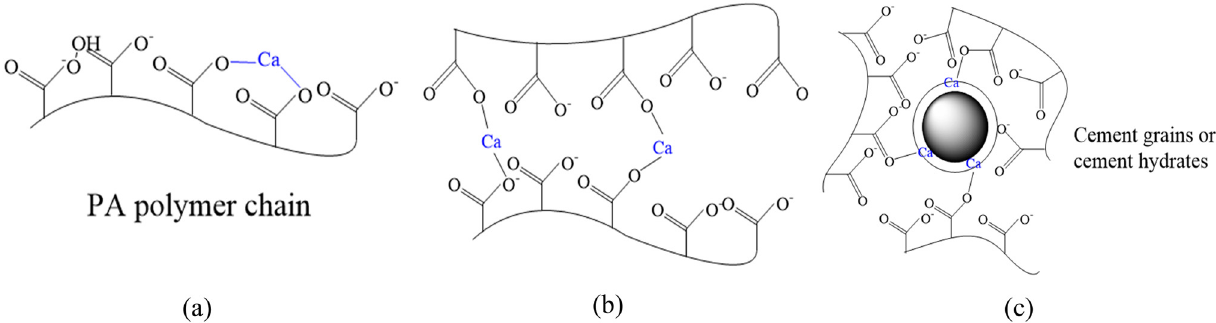
Figure 10: Reactions between Ca 2 + and polyacrylate ( PA ) polymer chain: ( a ) self - link of polymer chain; ( b ) cross - link of PA polymer chains; ( c ) cross - link between PA polymer chain and cement